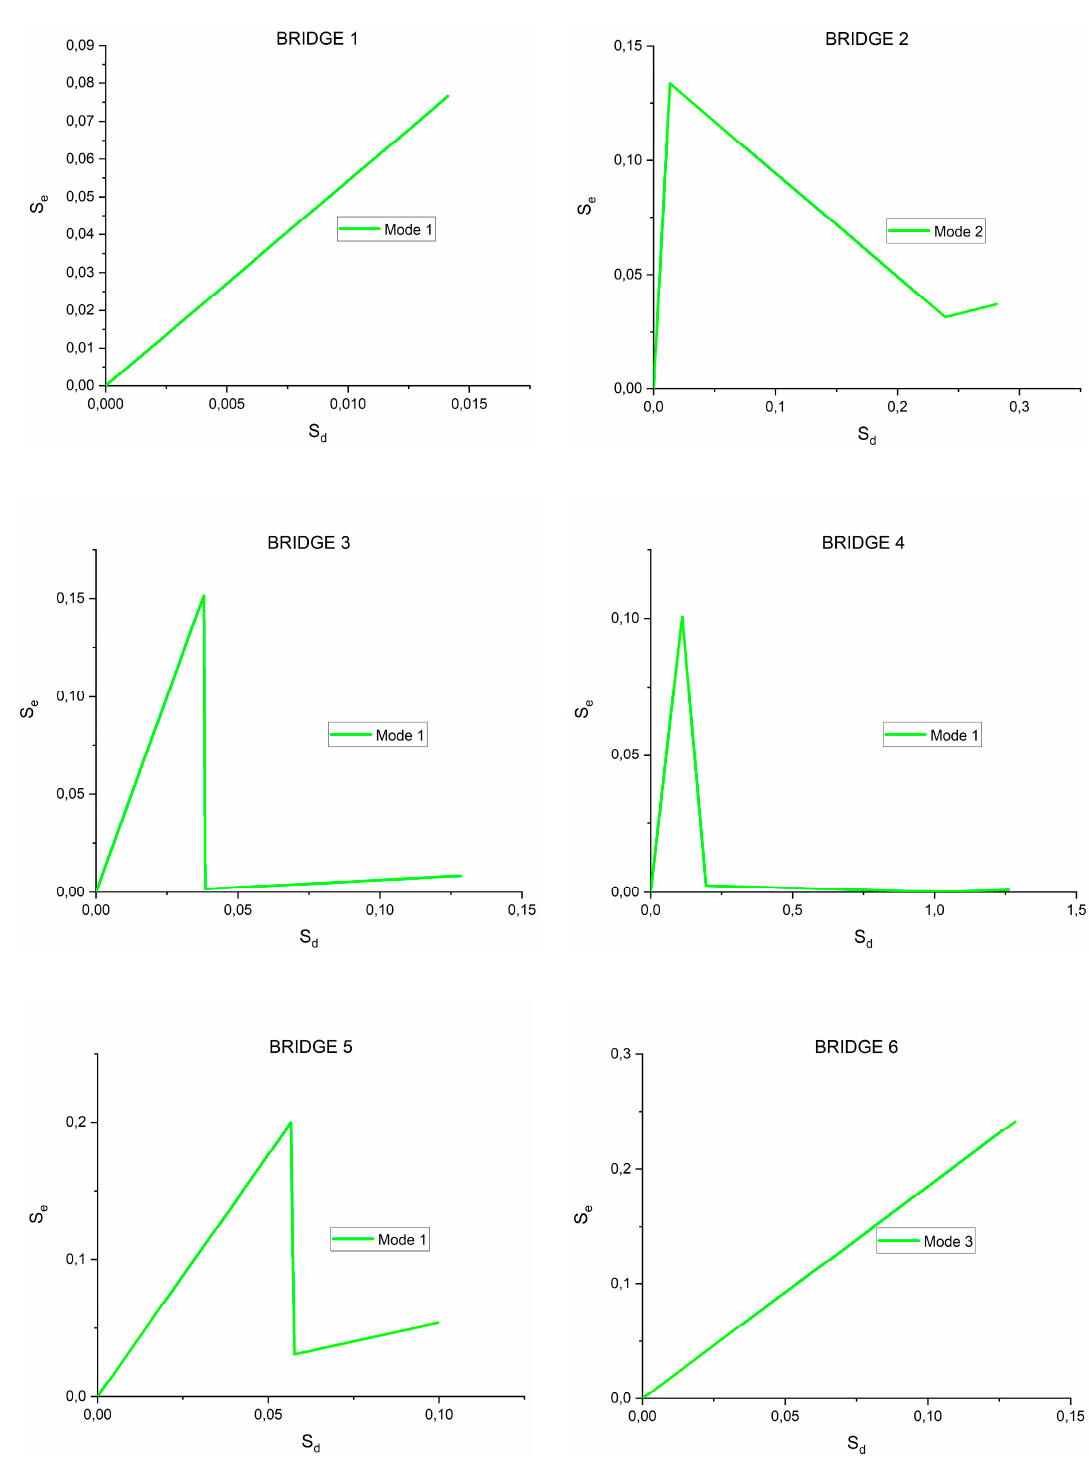
Figure 13. Capacity curves for brittle mechanism (S e [1/g]–S d [m]).